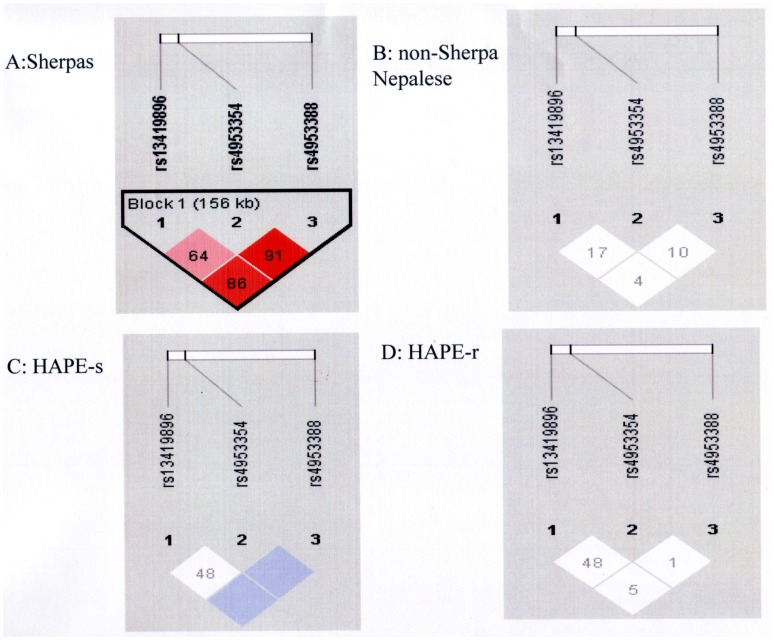
Linkage disequilibrium of the three single nucleotide polymorphisms.Linkage disequilibrium of the three EPAS1 single nucleotide polymorphisms in Sherpas (A), non-Sherpa Nepalese (B), Japanese high-altitude pulmonary edema-susceptible subjects (HAPE-s; C) and Japanese high-altitude pulmonary edema-resistant subjects (HAPE-r, D). D’ values appear in the diamonds. Red, D’>0.8 with logarithm of the odds (LOD)≥3; pink, D’<0.8 with LOD≥3; blue, D’>0.8 with LOD<3; white, D’<0.8 with LOD<3.